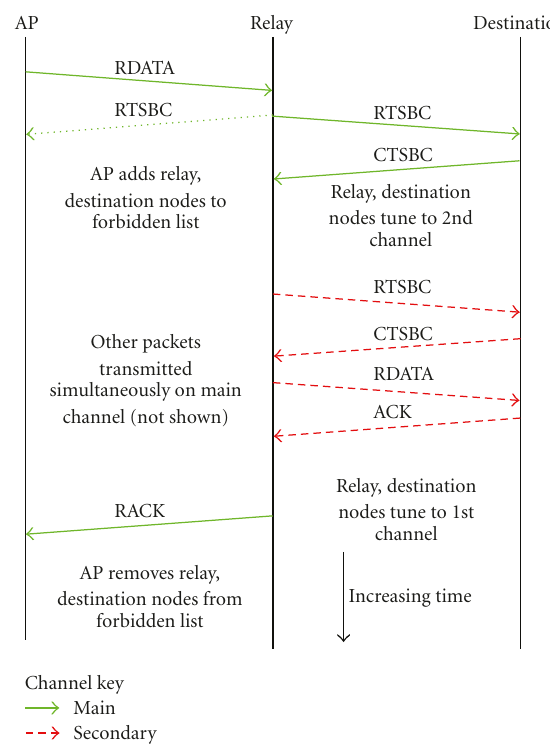
Figure 4: Step By Step Illustration: relaying a Packet. Primary chan- nel transmissions as solid lines, borrowed channel transmissions as dashed